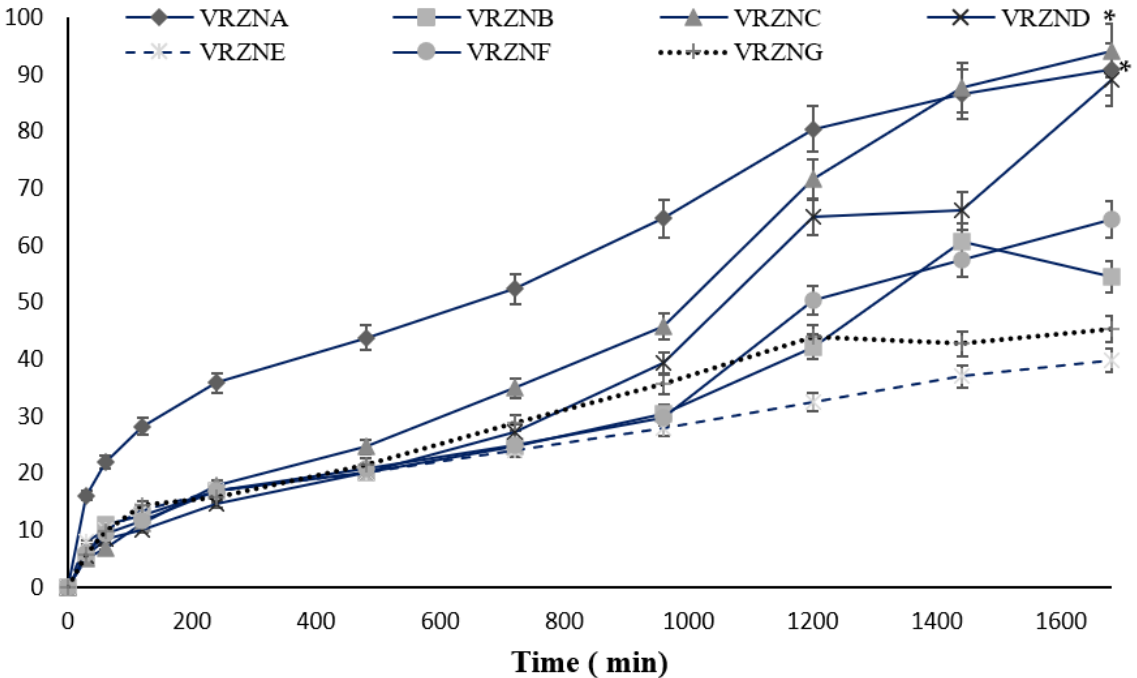
Figure 3. In vitro average of % drug release of formulations: n = 3, mean ± S.D., * p < 0.05 considered statistically signifi- cantly different from VRZNB, VRZND, VRZNE, VRZNF, and